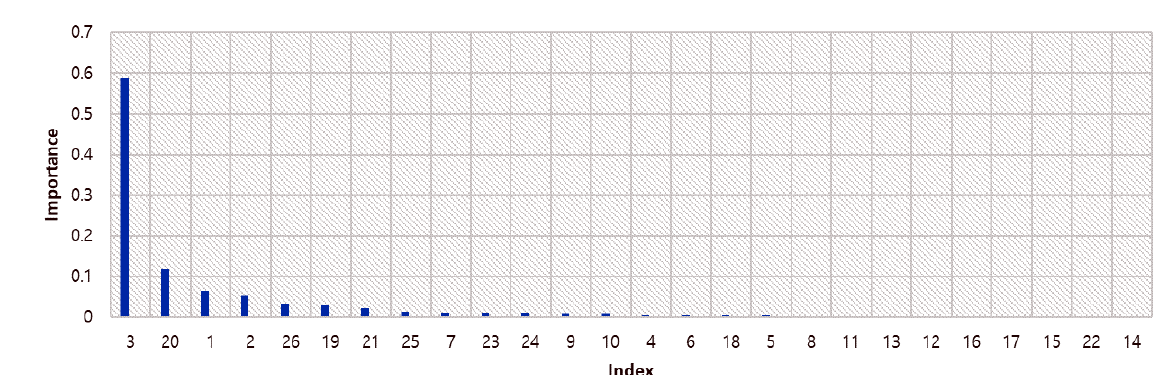
Figure 4. Importance of features in the trained RF model. “Importance” means the contribution of each variable to the model